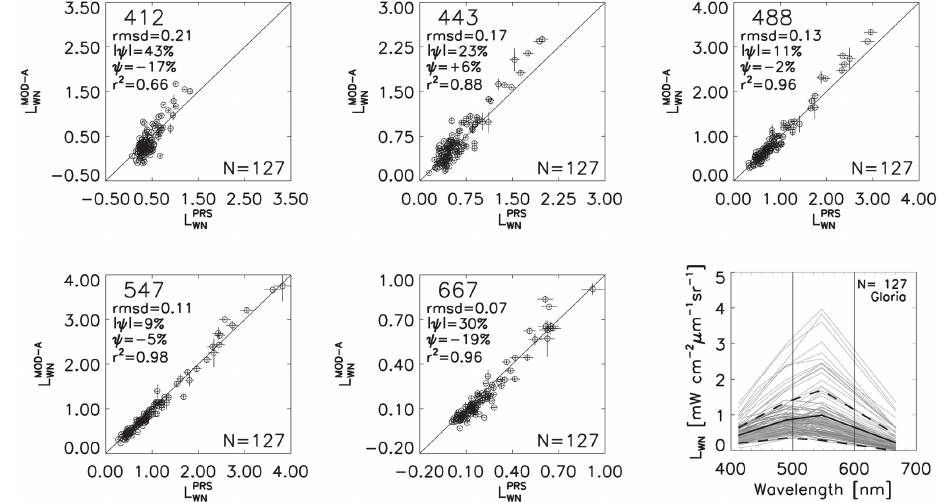
Figure 4. Scatterplots of MODIS-A (MOD-A) versus AERONET-OC (PRS) L WN match-up values at selected center wavelengths for the GLR site. N indicates the number of match-ups, L WN and RMSD are in units of mWcm − 2 µm − 1 sr − 1 , and | ψ | is the mean of absolute percent differences, while ψ is the mean of percent differences, and r 2 is the determination coefficient. The right panel in the second row displays the AERONET-OC L WN spectra utilized to construct match-ups.